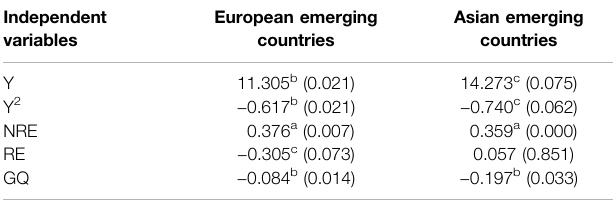
TABLE 4 | AMG long-run estimation results Independent